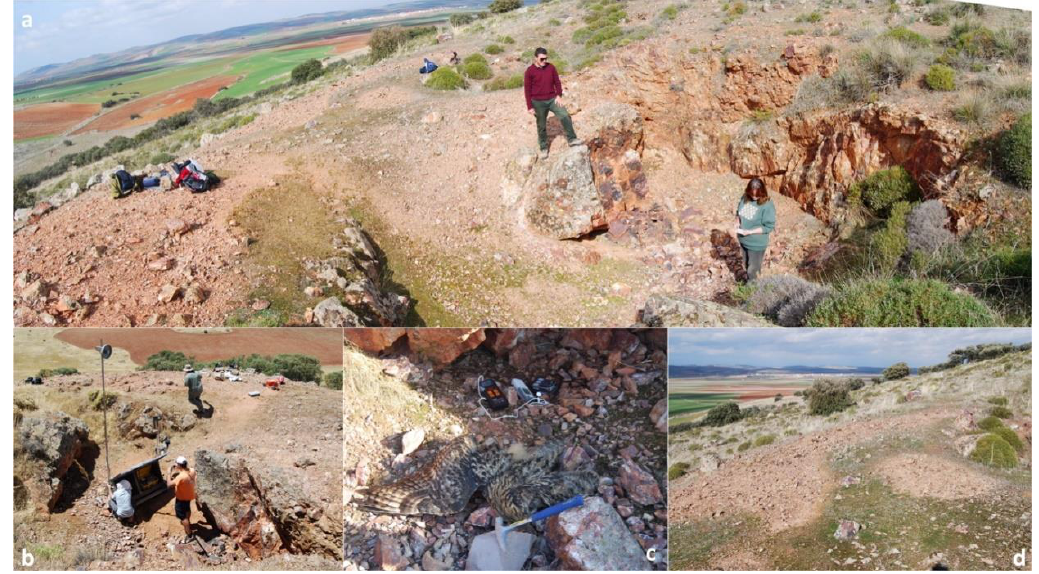
Figure 8. ( a ) La Sima degassing vent main crater; ( b ) volcanic gas monitoring station; ( c ) dead owl inside the main crater; ( d ) degassing points without vegetation.